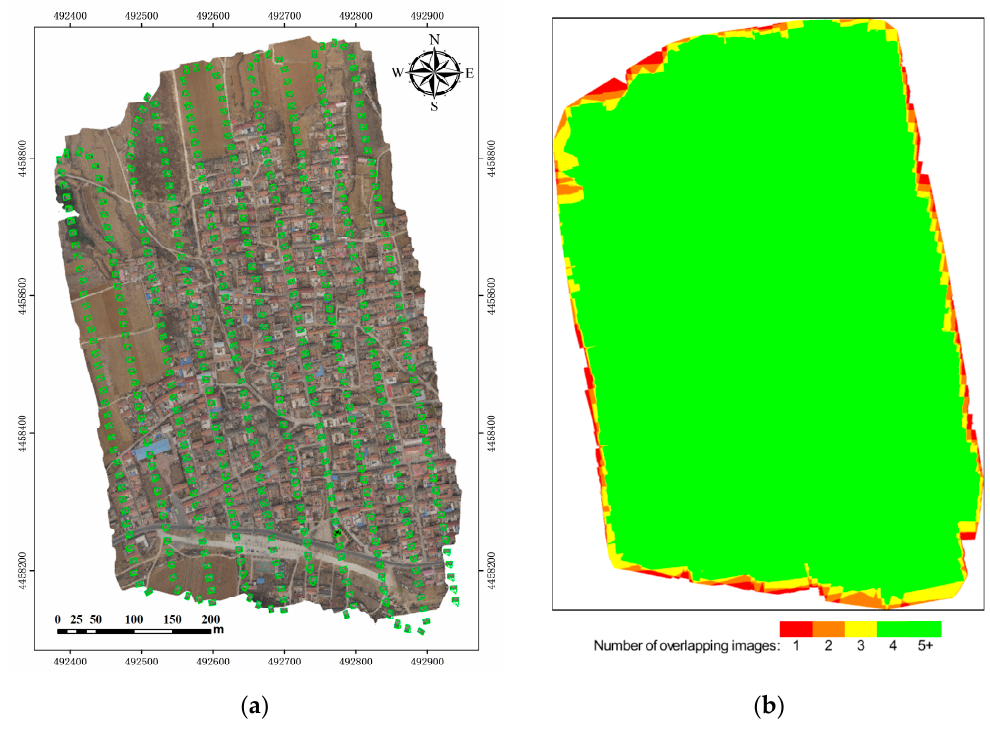
Figure 6. Images showing ( a ) restoration of the camera exposure location and UAV trajectory using the SfM algorithm and ( b ) the overlap of the digital orthophoto map (DOM) with the UAV point cloud; areas masked in green indicate an overlap of more than five images.